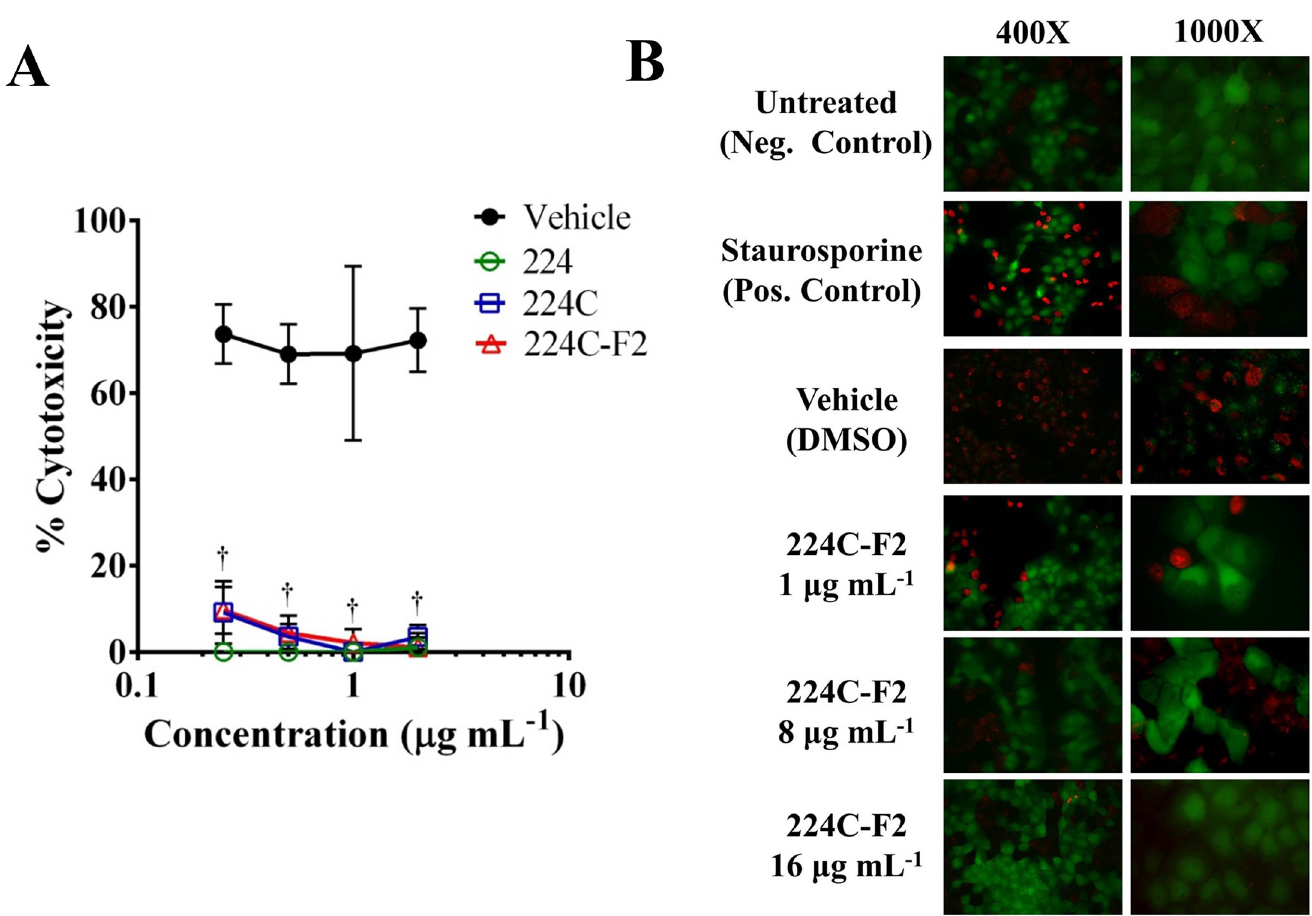
Fig 5. Spent supernatants of S . aureus treated with 224C-F2 exhibit diminished cytotoxic effects against human keratinocytes. (A) Supernatants were applied to HaCaT cells (20% v/v for 24 hrs) to measure the lytic capacity (determined by LDH assay) of a full suite of S . aureus exotoxins. Supernatants from 224C-F2-treated cultures were non-toxic to the mammalian cells, confirming inhibition of exotoxin production. (B) Following exposure to supernatants (14% v/v for 3 hrs) or staurosporine (7.1 μ M for 3 hrs), HaCaT cells were imaged by fluorescent microscopy to examine cell integrity. Green cells are live, red are dead. Black regions are indicative of dead cells that have detached from the slide. Significant differences between treatment and vehicle are represented as: * : p < 0.05; ‡ : p < 0.01; † : p < 0.001.